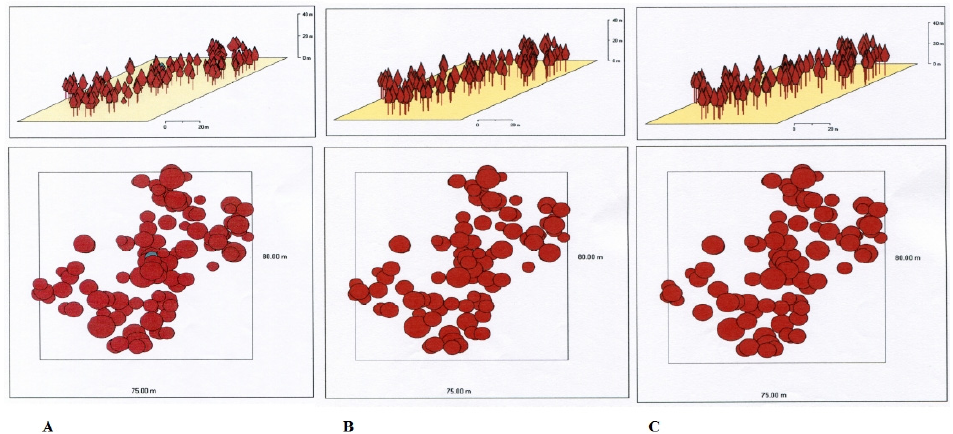
Figure 3. Growth simulation model for study site 2 (alochtonous Norway spruce forest) under a non ‐ intervention management: status quo ( A ), and visualization of the future forest development for the period of 25 years ( B ) and 50 years ( C ). Red = Picea abies, blue = Sorbus aucuparia . the period of 25 years ( B ) and 50 years ( C ). Red = Picea abies , blue = Sorbus aucuparia